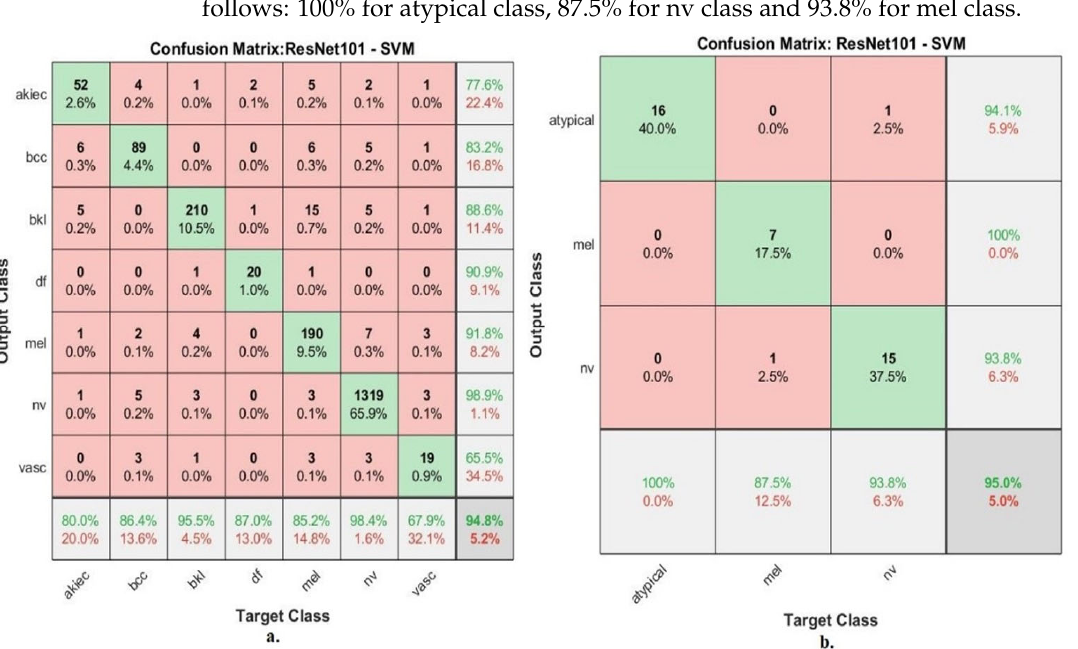
Figure 11. Confusion matrix for the classification of two skin lesion datasets by SVM with MobileNet features through datasets of ( a ) HAM10000 and ( b ) PH2.